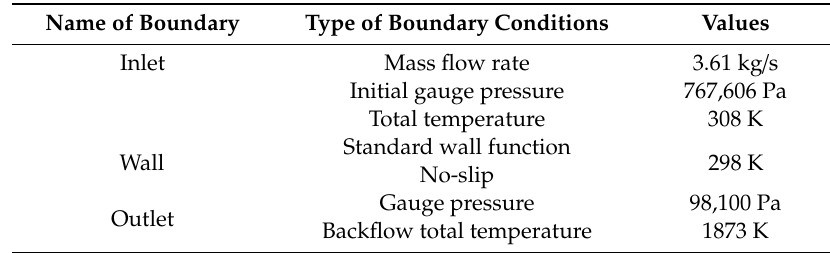
Table 2. Specifications of the boundary conditions.